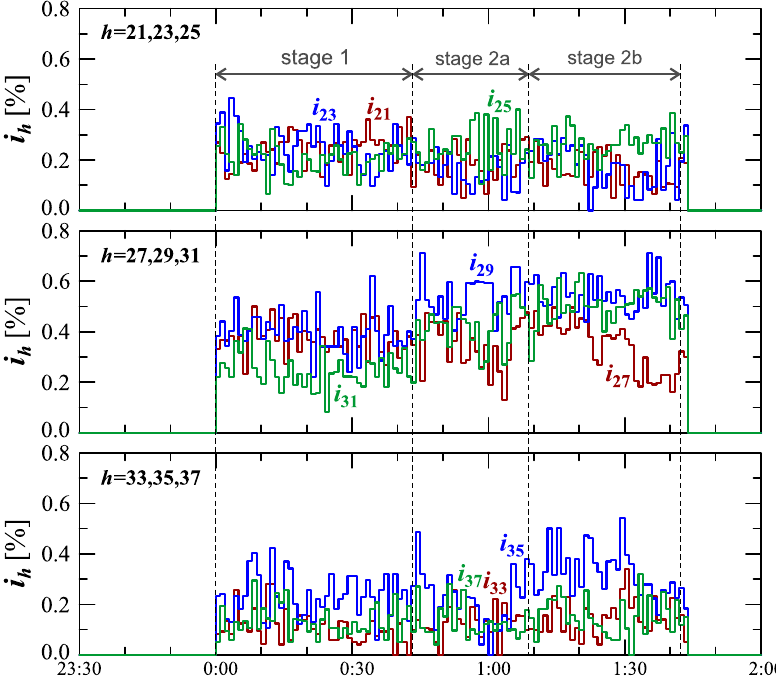
Figure 9. The characteristics of odd harmonics of the current i h = f ( t ) from the order h = 21 to 37 for Case